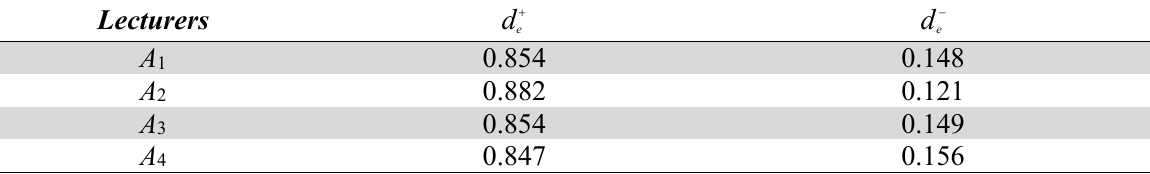
Distance measurement